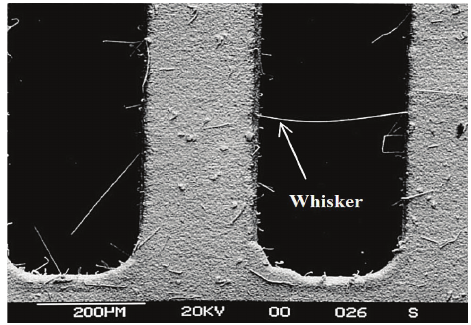
Figure 13: SnAgCu-Ce surface whisker